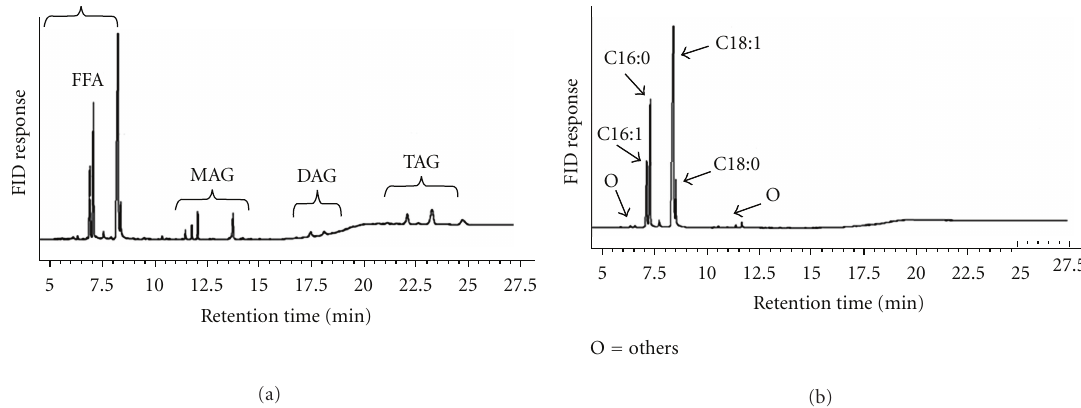
Figure 3: GC chromatograms of neutral lipid before saponification (a) and fatty acid profile after saponification with KOH and ethanol (b).